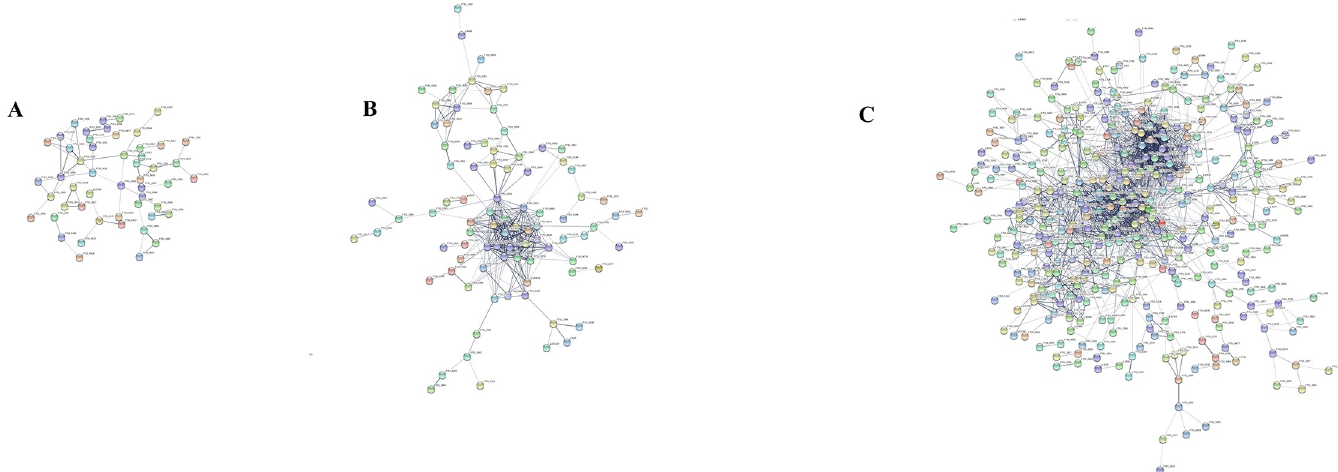
Fig 6. PPI networks of co-expressed meta genes in brown module at LG (A), TR (B), and PR (C) phases. Changes in intra-module connectivity are highlighted at different phases.